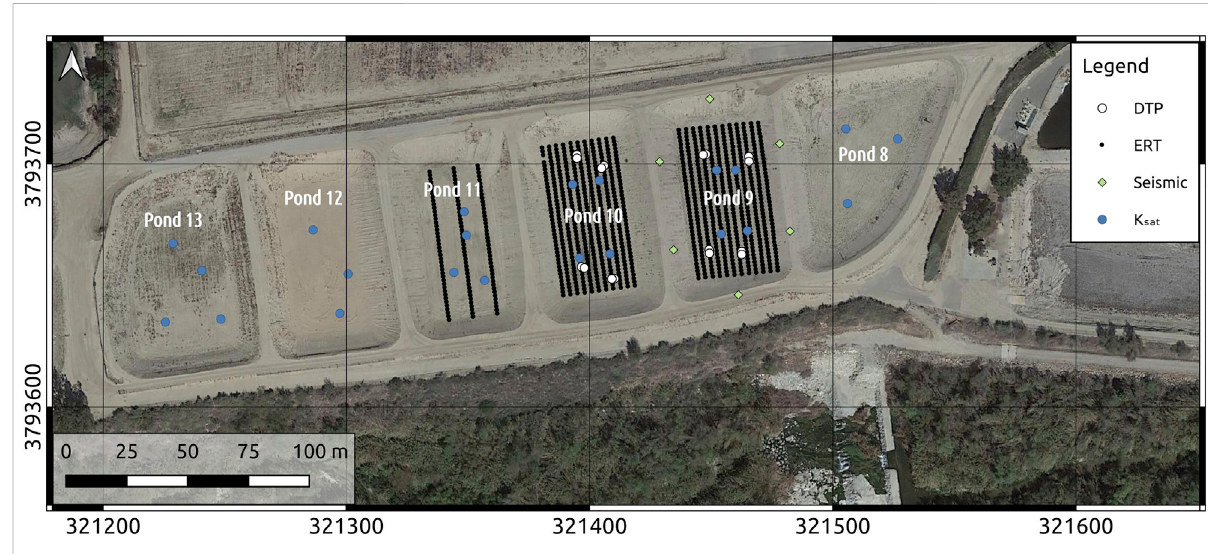
FIGURE 1 Map of the study site showing the investigated in fi ltration ponds (Ponds 8 to 13 in which EMI data were acquired), the locations of ERT electrodes, in fi ltration and DTP probes, ambient seismic noise sensors, and measurements of saturated hydraulic conductivity. Aerial photograph obtained from NOAA. Coordinates in NAD83 UTM Zone